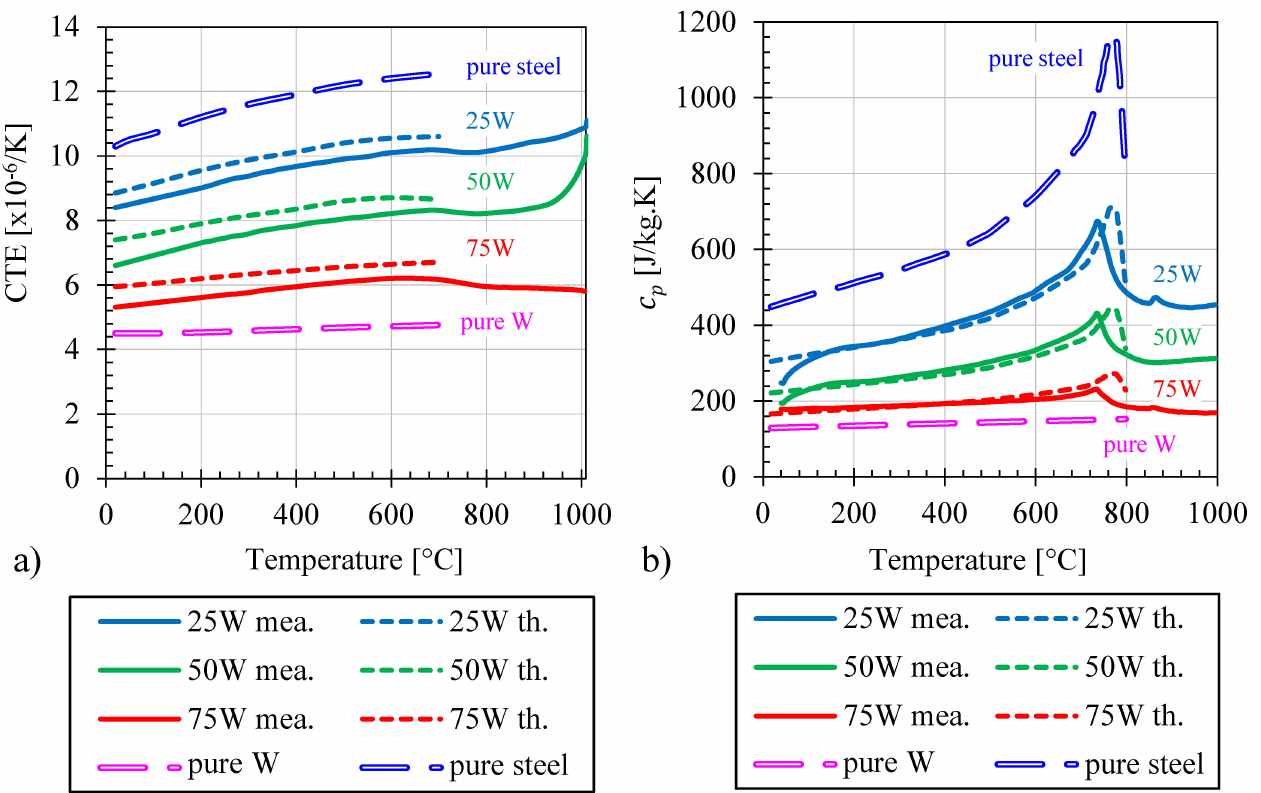
Figure 10. ( a ) Secant CTE; ( b ) Specific heat capacity of the composites in comparison to their theoretical values. In addition, values of pure W and pure Eurofer 97 steel [24–26].